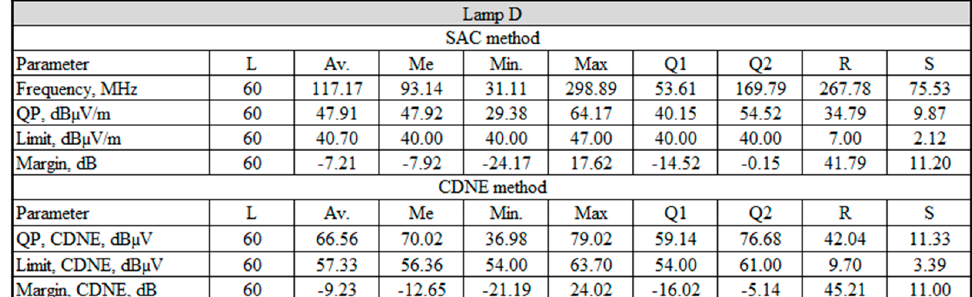
Figure 13. Recorded QP values using the new and traditional method against the allowable limits for the tested 18 W LED lamp D.